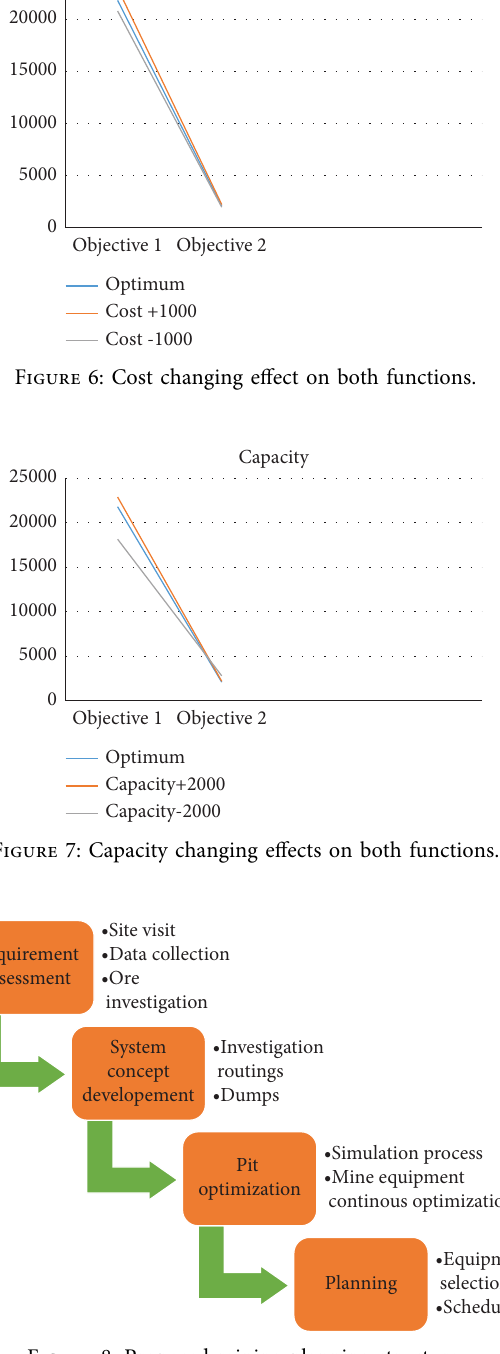
Figure 8: Proposed mining planning structure.